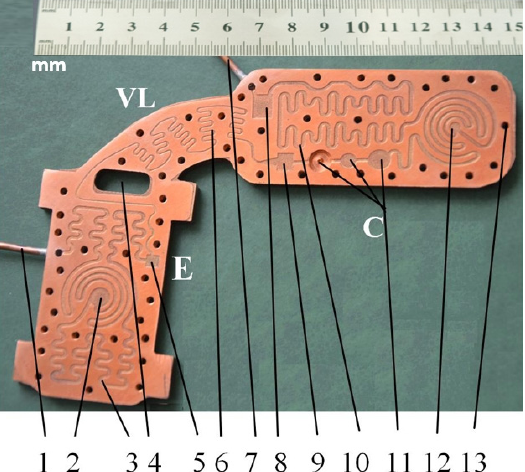
Figure 2. Condenser, lamination tube and the vaporizer of the mini refrigerating unit: 1—vaporizer drainage tube; 2—central area of the vaporizer; 3, 10—rectangular microchannels of the vaporizer, condenser, 4—shaft; 5, 8—mini filters; 6—rectangular microchannels in the lamination area; 7—compressor intake tube; 9—convergent nozzle; 11—mini liquid coolant tanks; 12—condenser